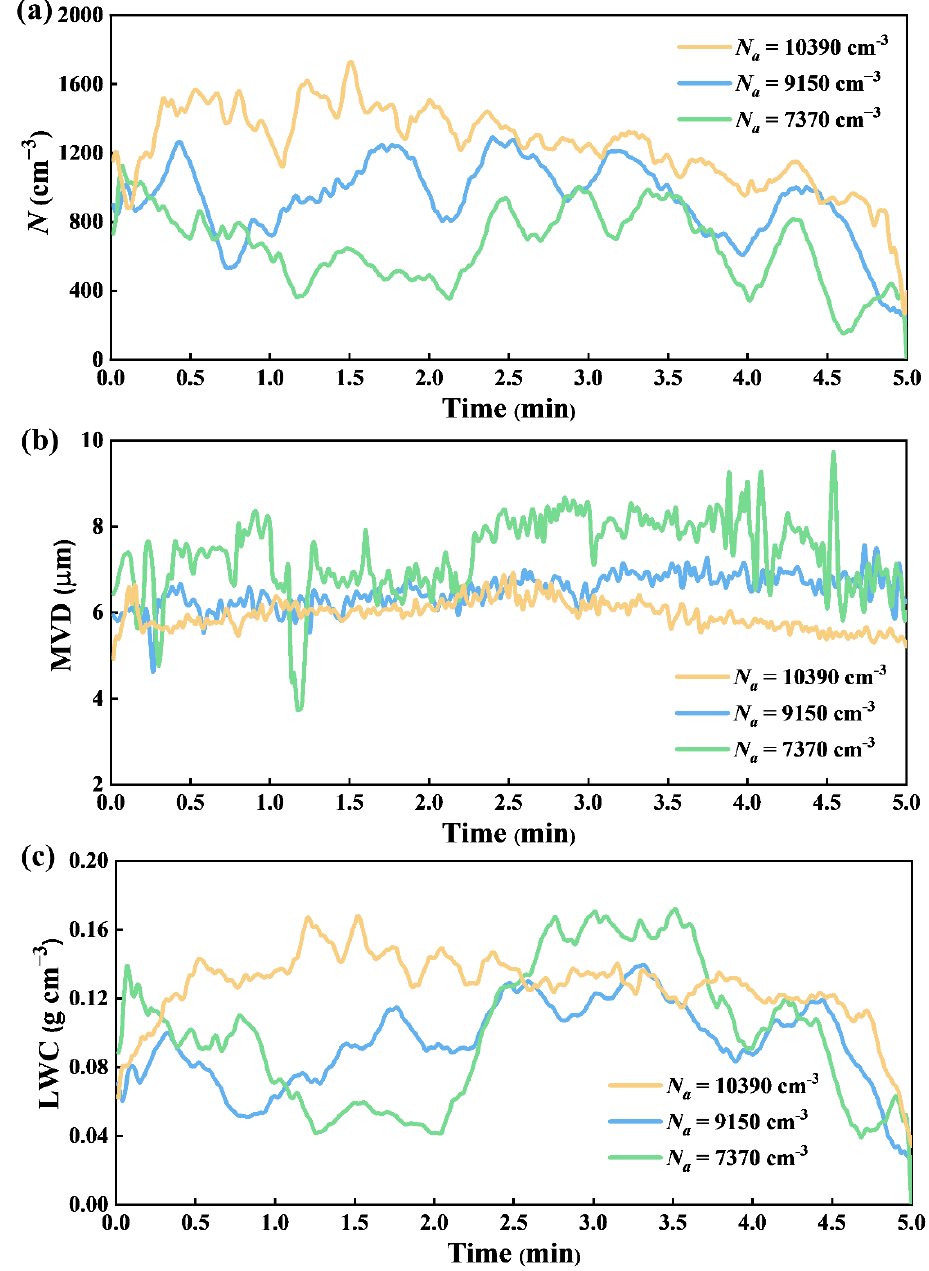
Figure 11. The microphysical parameters of cloud droplets under the different aerosol number concentrations. ( a ) Time-series variation in N . ( b ) Time-series variation in MVD. ( c ) Time-series variation in LWC.